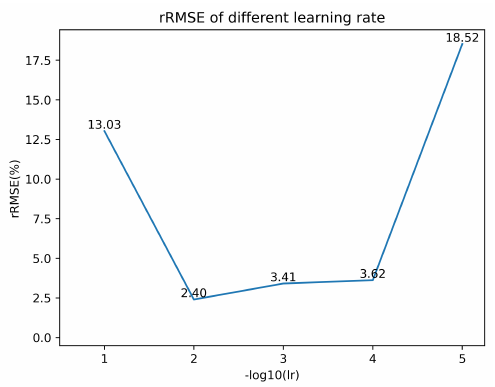
Figure 10. Effect of different learning rates on model prediction